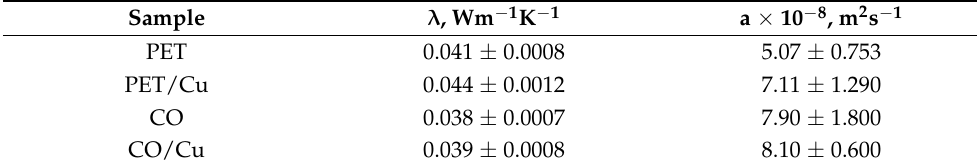
Table 7. Results of the Alambeta